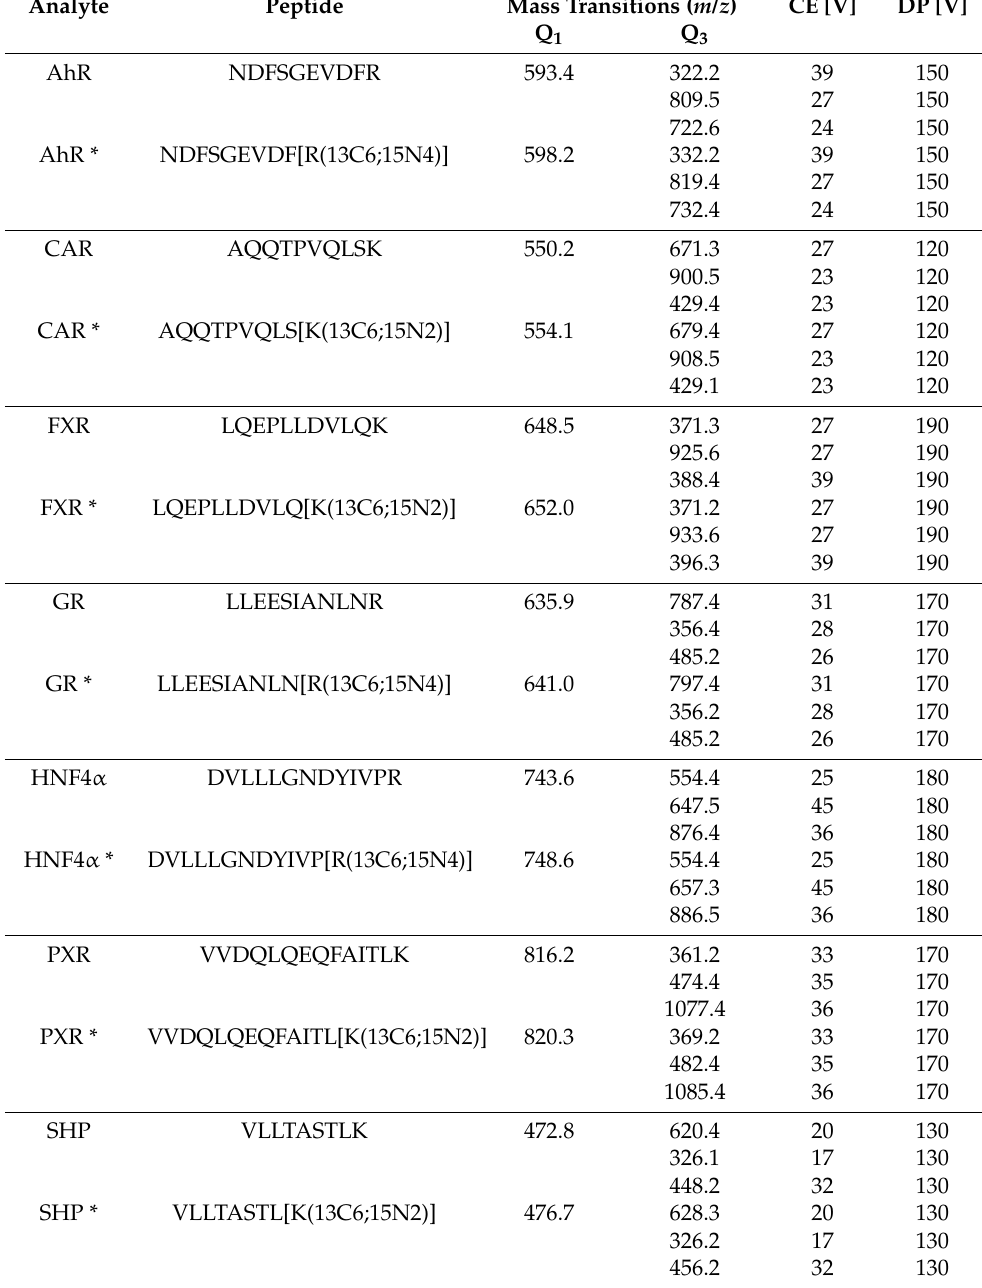
Table 1. Overview of used proteospecific peptides and mass spectrometry parameters for their detection in the positive multiple reaction monitoring mode (MRM). Dwell time was automatically optimized (scheduled MRM algorithm). CE, collision energy; DP, declustering potential; m / z , mass- to-charge ratio.